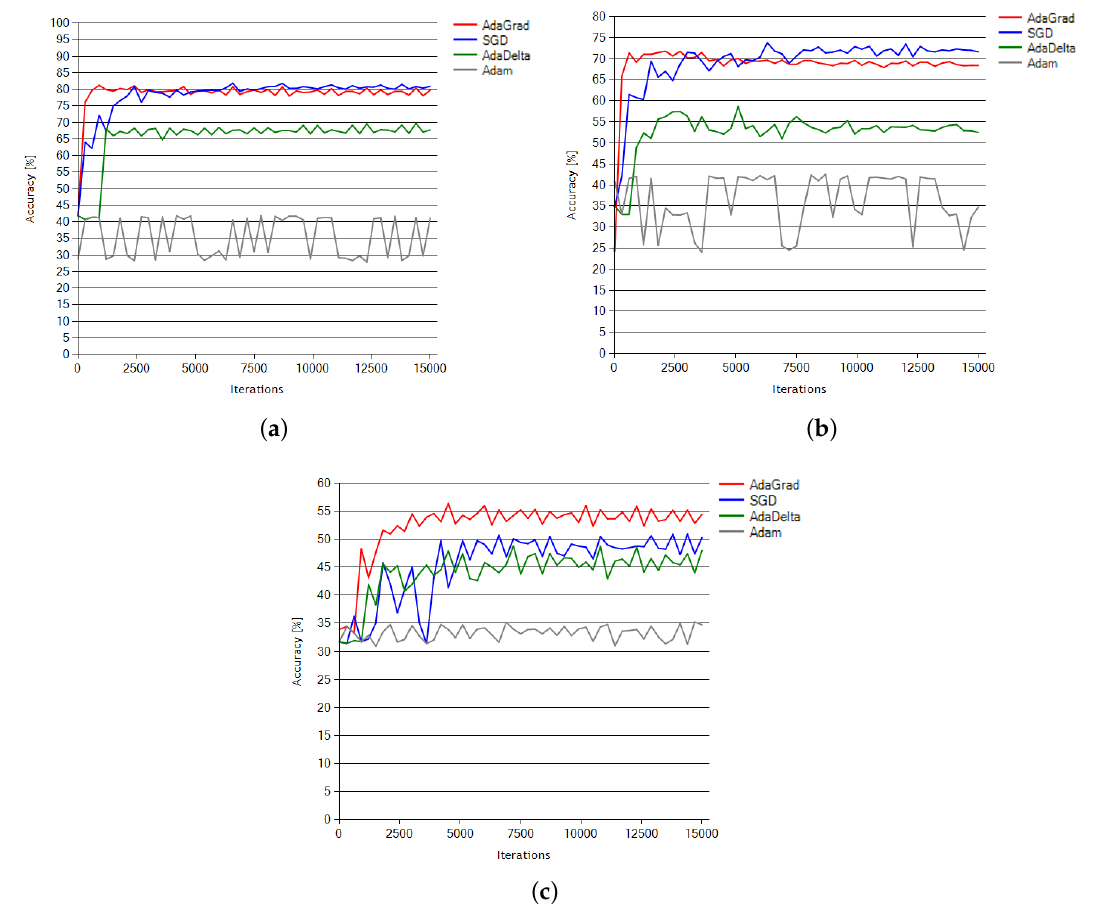
Figure 8. ( Top ) Learning curves for Subject 1 and 2 dataset training; and ( Bottom ) learning curves for Subject 3 dataset training.